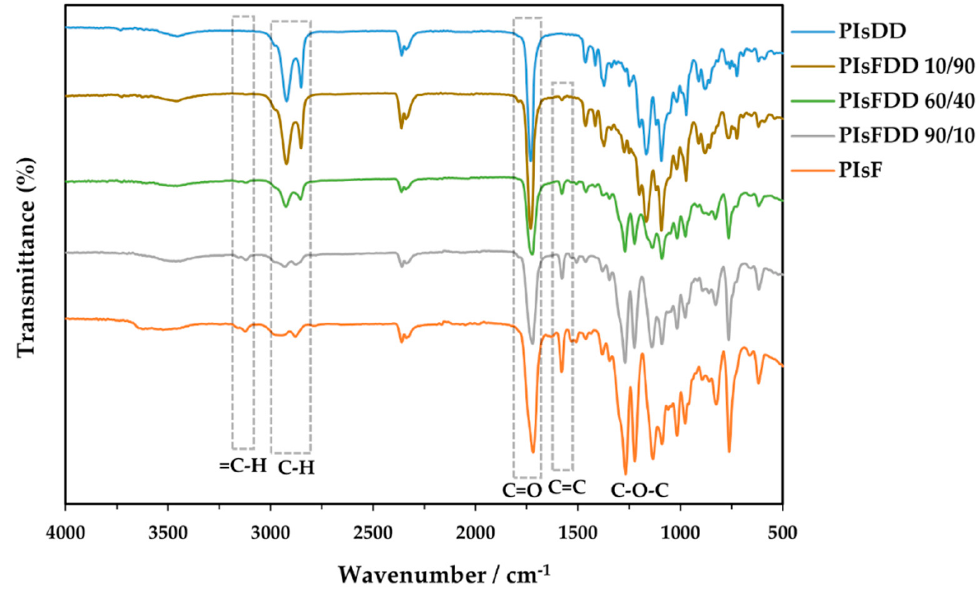
Figure 1. ATR-FTIR spectra of selected PIsFDD copolyesters and related PIsF and PIsDD homopol- yesters.